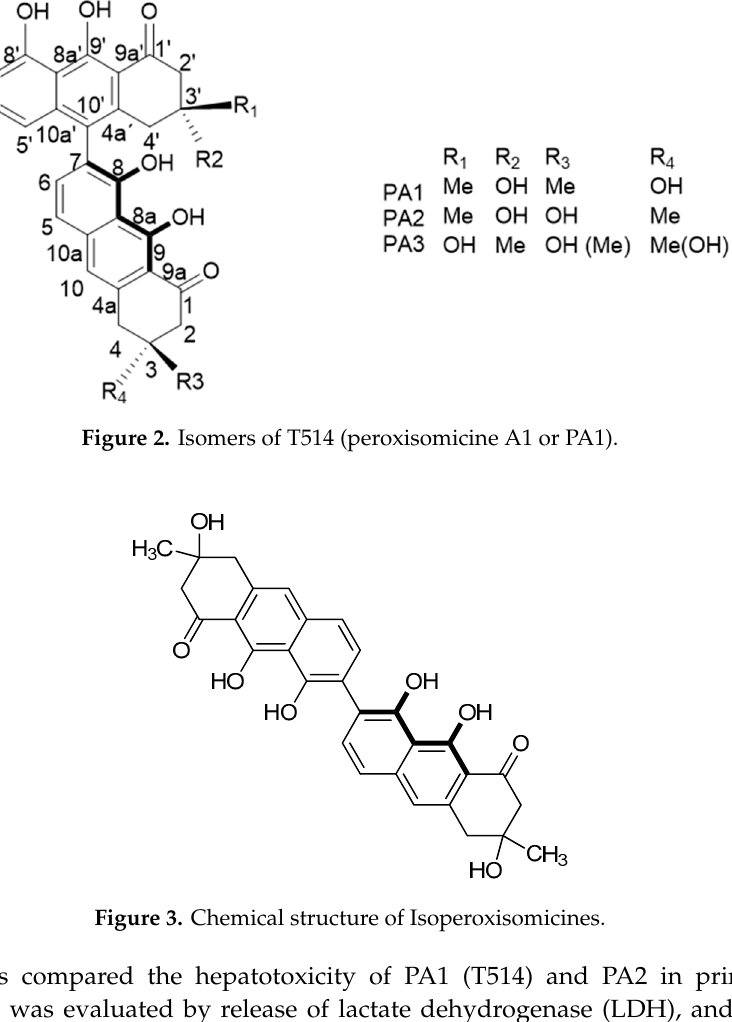
Figure 1. Chemical structures of the four toxins isolated from K. humboldtiana .